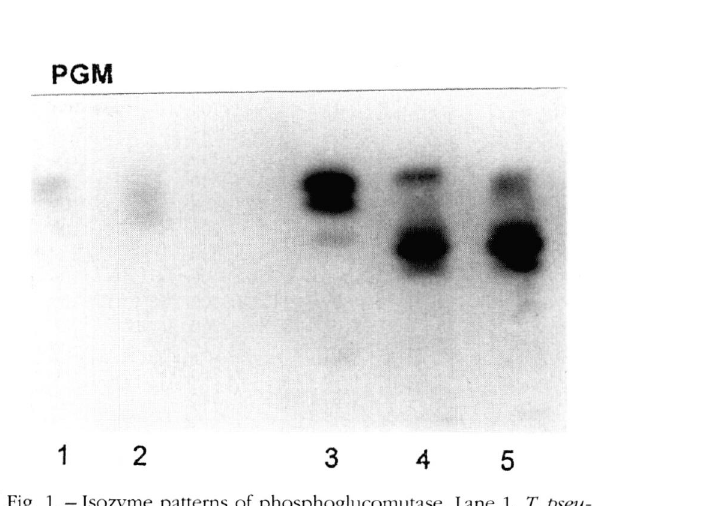
Fig. 2. — Isozyme patterns of adenosine deaminase. Lane 1, T. pseudospiralis (Caucasus, raccoon dog); lane 2, T. pseudospiralis (USA, black vulture); lane 3, T. pseudospiralis (Australia, tiger cat); lane 4, T. spiralis (USA, pig) ; lane 5, T. britovi (Italy, wolf).